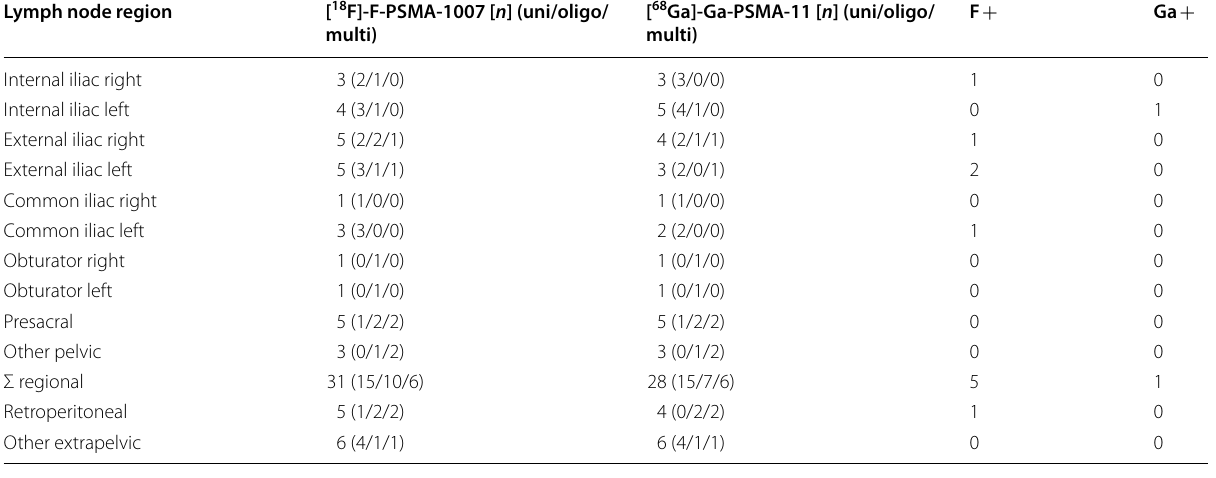
Table 6 Lymphonodal uptake by region Lymph node region